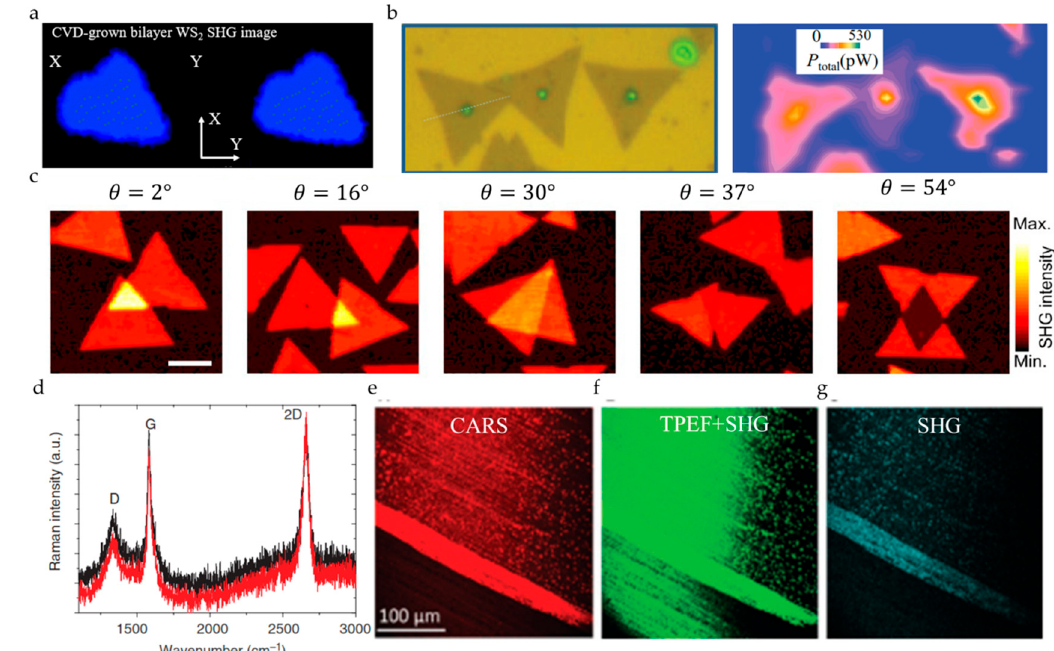
Figure 10. ( a ) SHG image of the CVD-grown bilayer WS 2 . Reproduced from [62], with permission from American Chemical Society, 2014. ( b ) Left panel: Optical microscopy photograph of a region of a substrate containing MoS 2 flakes grown by CVD. Right panel: SHG microscopy photograph of the same region. Reproduced from [87], with permission from American Physical Society, 2018. ( c ) SHG intensity mapping of artificially stacked MoS 2 bilayers with various stacking angle ( θ ). Reproduced from [62], with permission from American Chemical Society, 2014. ( d ) The Raman spectrum of graphene grown on unpolished Cu foils. ( e ) The CARS (Raman shift of 1360 cm − 1 ). ( f ) The TPEF + SHG; ( g ) The SHG image of graphene. Reproduced from [95].